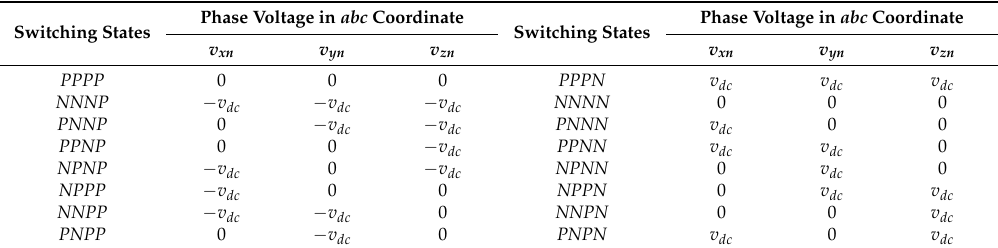
Table 1. The switching states with phase voltages in the abc coordinate.